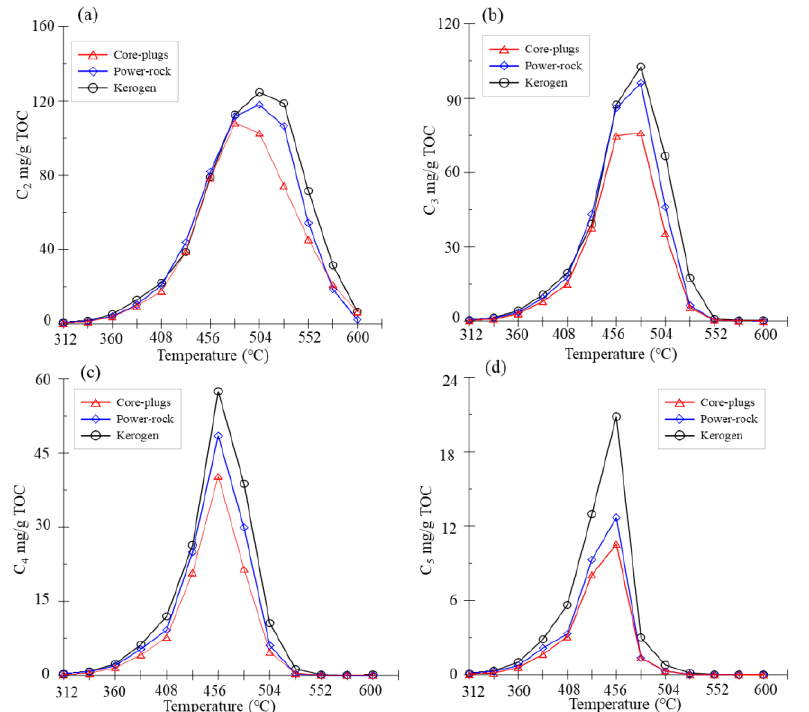
Figure 5. Individual gaseous hydrocarbon yield generated by pyrolysis of core plugs, powdered rock and kerogen of Maoming oil shale. ( a ) Ethane (C 2 ); ( b ) propane (C 3 ); ( c ) butane (C 4 ); ( d ) pentane (C 5 ).